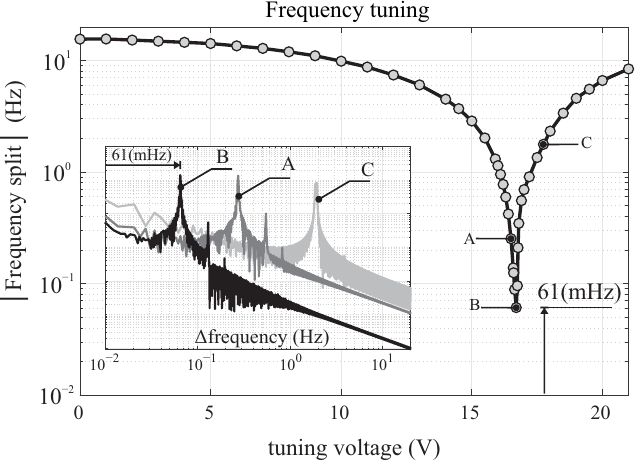
Figure 11. Estimation of | ∆ f | by monitoring the peak in the power spectrum of the nearly-matched region for a high Q-factor device. Inset figure shows the PSD of the drive signal at the corresponding reference points. Results are